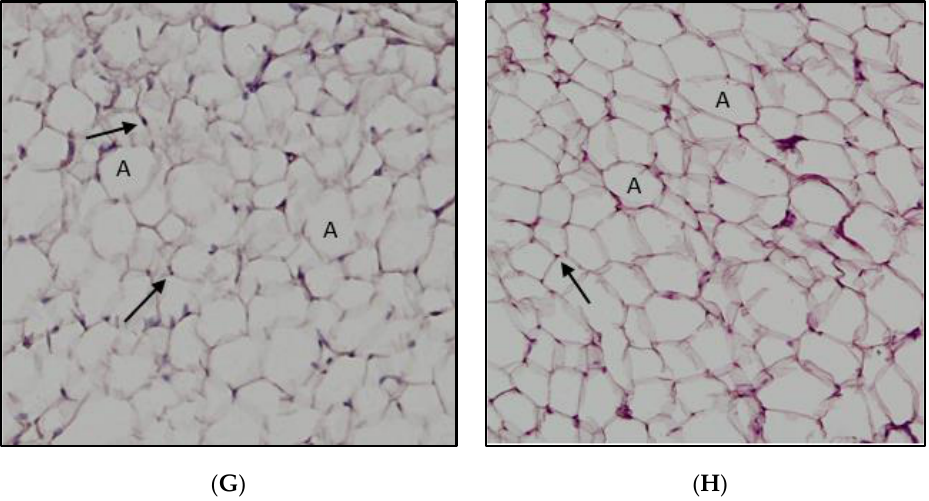
Figure 5. Cross-section of the rat adipose tissue stained with haematoxylin and eosin. ( A ) Normal diet group. ( B ) Normal diet + DMH group. ( C ) High-fat diet group. ( D ) High-fat diet + DMH group. ( E ) High-fat diet + DMH + 5-FU. ( F ) High-fat diet + DMH + 125 mg/kg A. paniculata ethanol extract. ( G ) High-fat diet + DMH + 250 mg/kg A. paniculata ethanol extract. ( H ) High-fat diet + DMH + 500 mg/kg A. paniculata ethanol extract group (10× magnification). The arrows indicate the nucleus, and “ A ” indicates adipocytes.